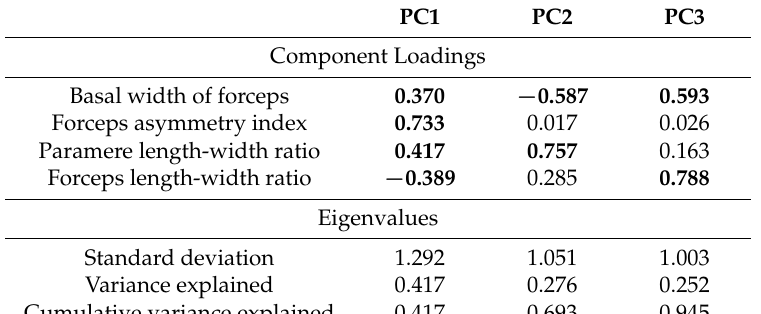
classification, the most informative variable was the paramere ratio (Table S3). However, the data did even when split by genus ( Anisolabis , H = 14.005, p = 0.001; Gonolabis , H = 62.871, p < 0.001). Table 1. Summary of principal component analysis measuring variation among male Anisolabididae specimens for seven morphometric variables related to primary and secondary male sex characteristics. Only principal components accounting for more than 10% of the total variation are shown. Component loadings with an absolute value greater than 0.3 are bolded. “Forceps asymmetry” is an index calculated as the sum of the absolute differences between the heights and widths of a specimen’s two forceps, “Paramere length-width ratio” is the ratio of a specimen’s right paramere’s length to its width, “Forceps asymmetry index” refers to an index calculated using the differences between the lengths and width of the two forceps, and “Forceps length-width ratio” is the ratio of the maximum forceps length to the maximum forceps width”. These three measurements were dimensionless while the basal width of the forceps was in mm.